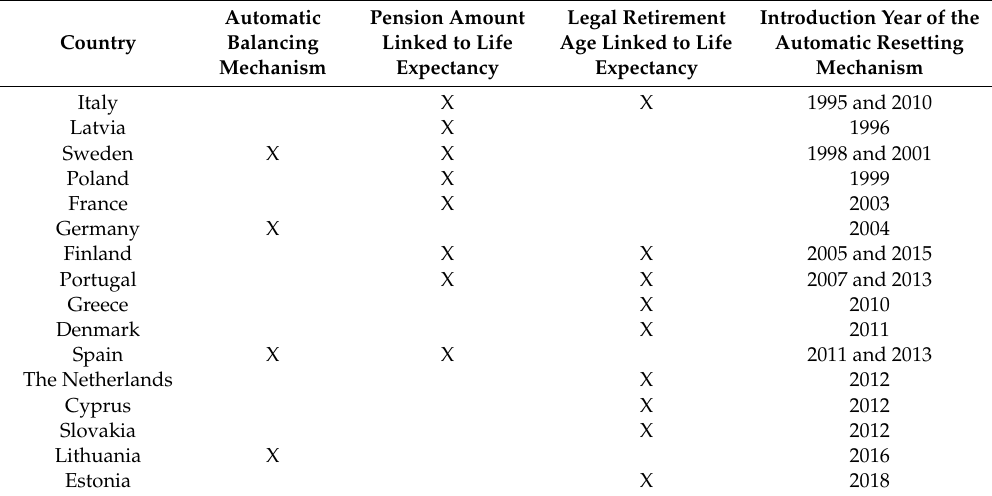
Table 1. EU countries with automatic resetting